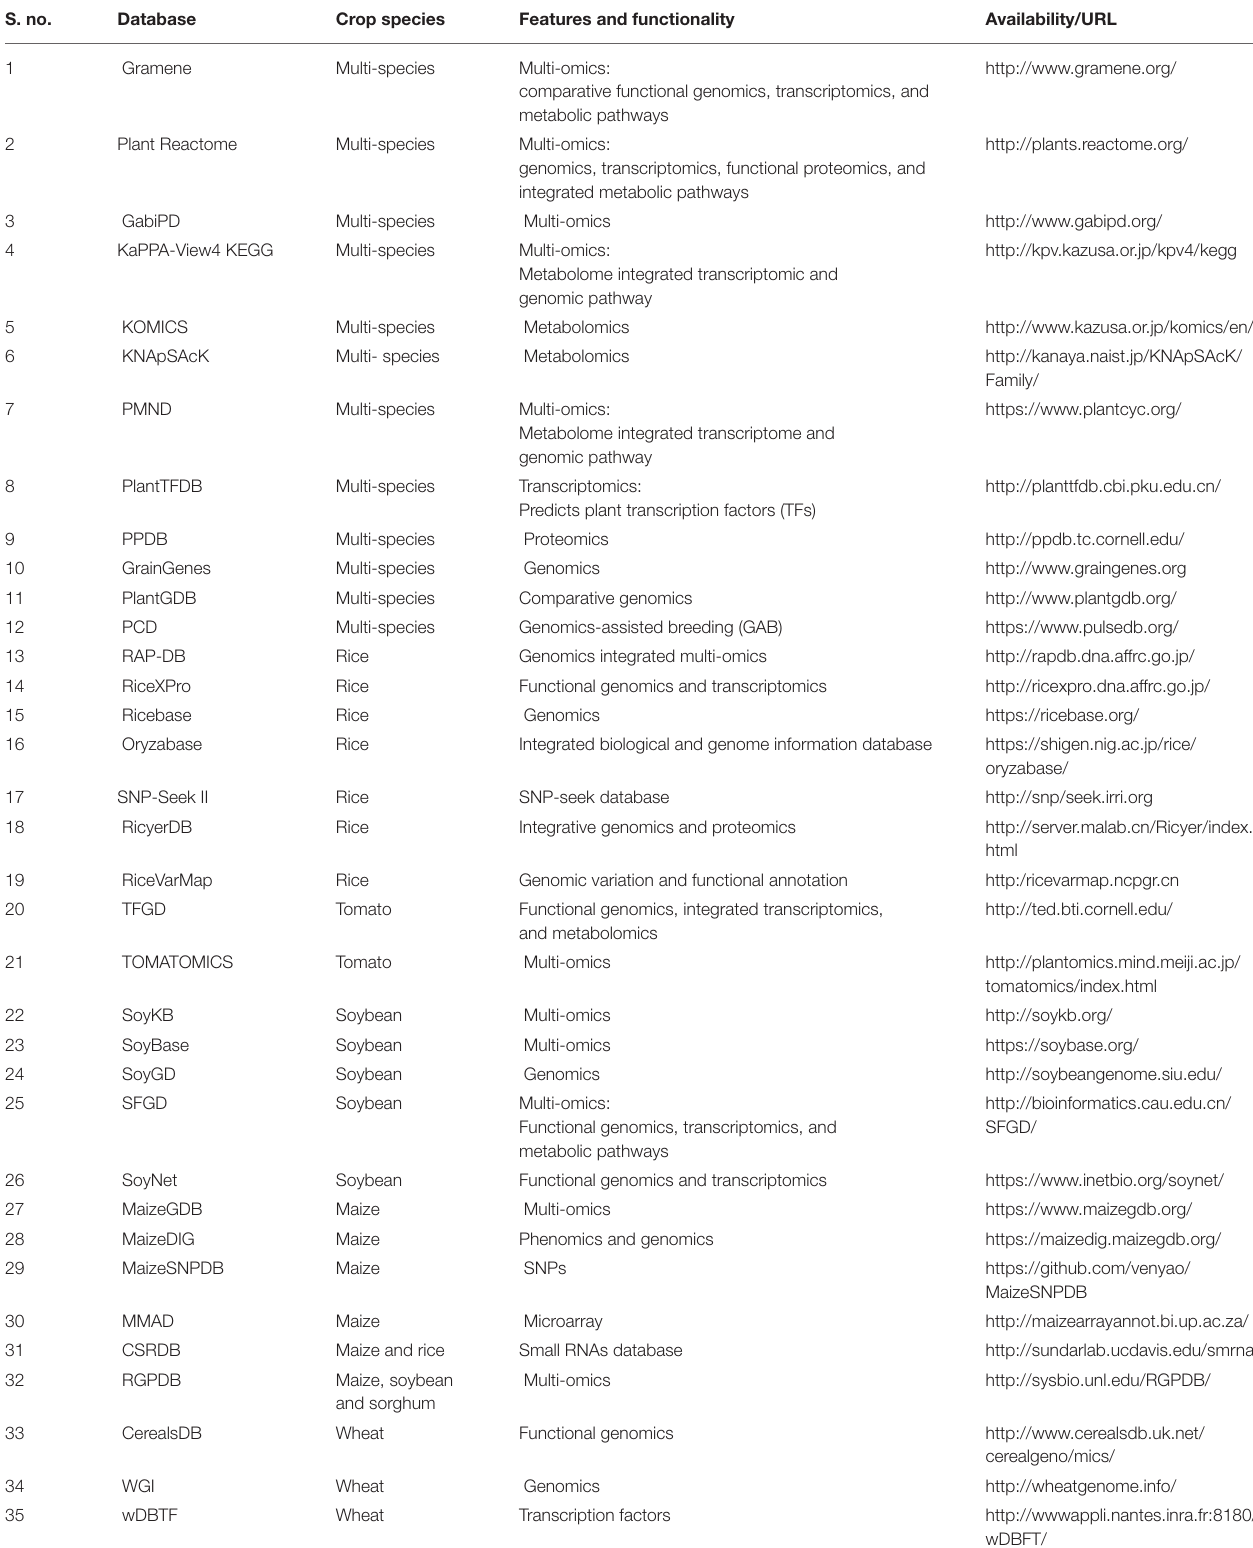
TABLE 1 | List of online databases used for crop multi-omics analysis. S.